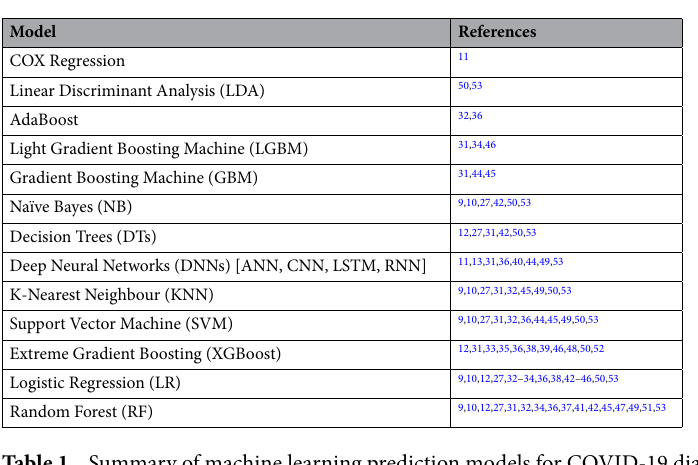
Figure 1. A general pipeline of DF-COVID-19